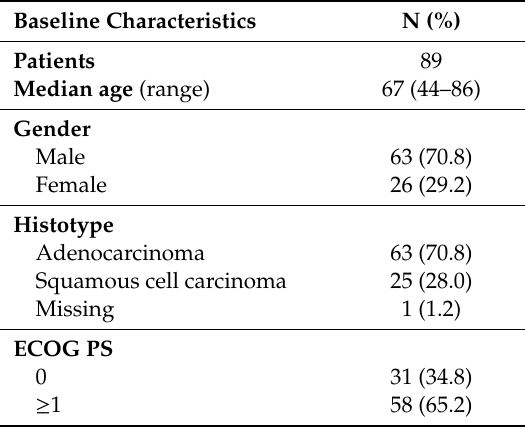
Table 1. Patients’ characteristics at